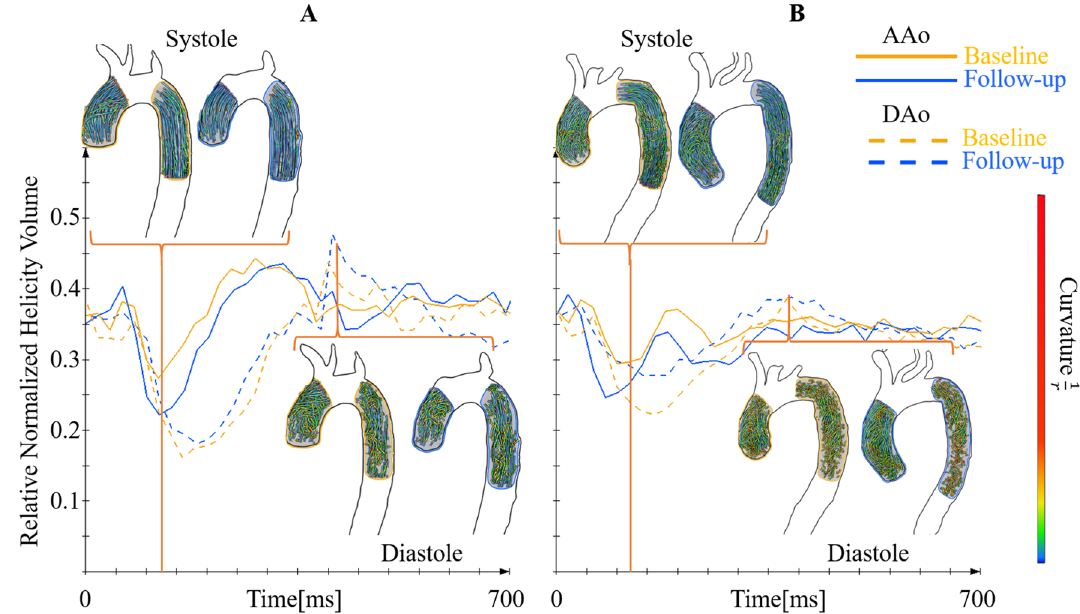
Figure 4. Changes in three-dimensional helicity over time. Examples for the development of the normalized thresholded relative helicity volume in the AAo and DAo segments are given in 27 year-old (( A ) left diagram) and a 79 year-old subject (( B ) right diagram). The yellow lines show the relative normalized helicity volume curves at baseline examination, the blue lines represent follow-up examination. The 3D visualizations show corresponding flow patterns as pathlines. The difference in the amount of helical flow in the ascending aorta (solid line) during systole is lower in the older subject. The difference in helicity between systole and diastole in the descending aorta increased in both subjects over